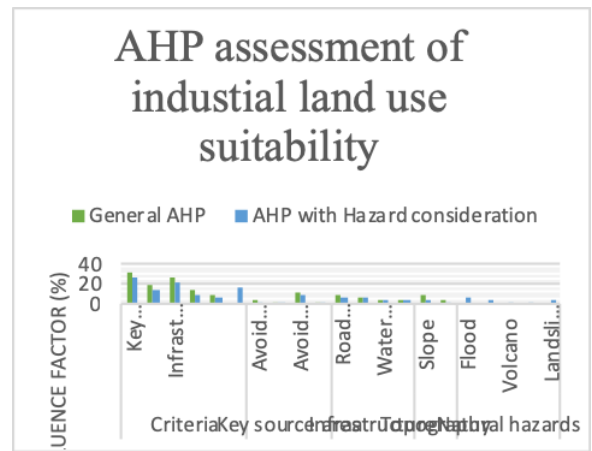
Figure 6. AHP weights of land-use suitability assessment for